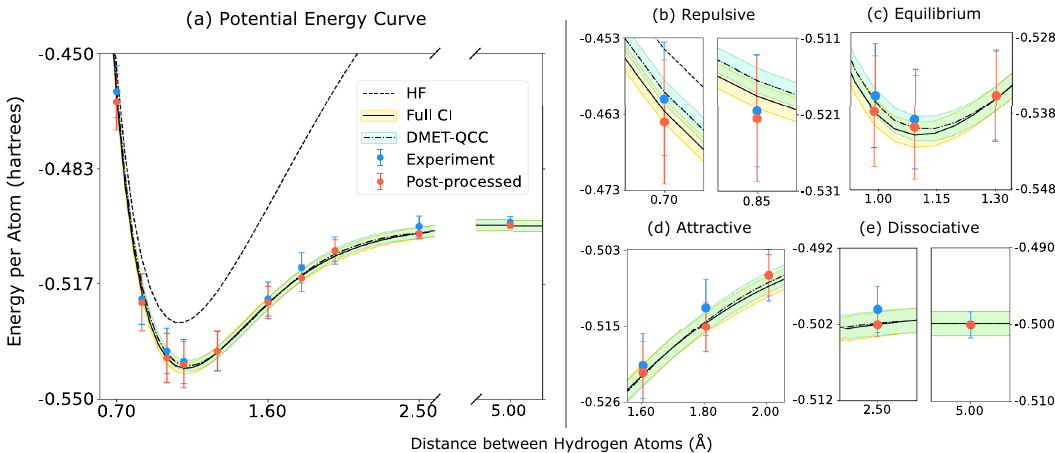
Fig. 2 The potential energy curve of the symmetric expansion of the ring of ten hydrogen atoms (H 10 ). For reference, we include classically simulated curves using several methods: Hartree – Fock (HF) shown with the dotted black line, full con fi guration interaction (full CI) shown with the solid black line, and density matrix embedding theory with the qubit coupled-cluster ansatz and variational quantum eigensolver (DMET-QCC) shown with the dashed black line. The full CI and DMET-QCC lines are surrounded by yellow and blue regions indicating chemical accuracy with respect to their values, and their overlap is indicated in green. The energies obtained by the experiment are shown in blue circles, and the post-processed energies are shown in red circles. The respective error bars for each are calculated using bootstrapping which is described in the “ Methods ” section. a The full potential energy curve. b – e A magni fi ed view of the distinct energy regimes of the